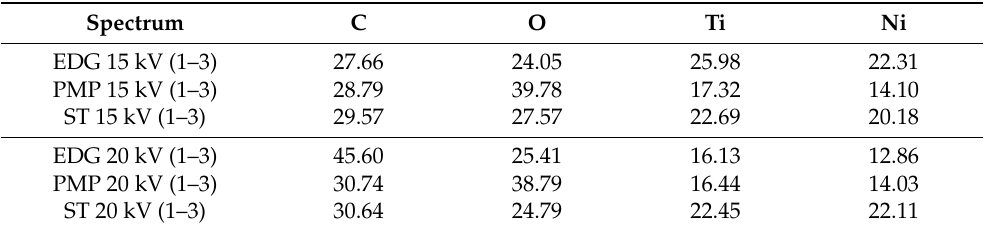
Table 2. Mean atomic weight percentages (%) of EDG NiTi alloy endodontic rotary file, PMP heat- treated NiTi alloy endodontic rotary file, and ST heat-treated NiTi alloy endodontic reciprocating file at 15 and 20 kV in three different locations (1–3).